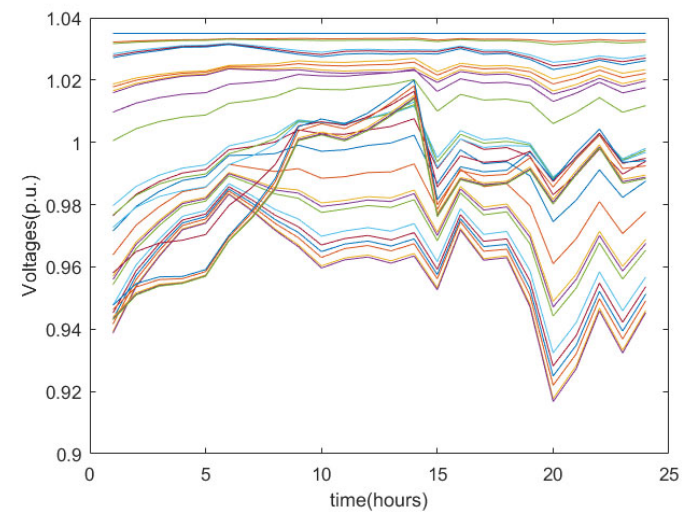
Figure 20. Node voltages (optimization level 4).